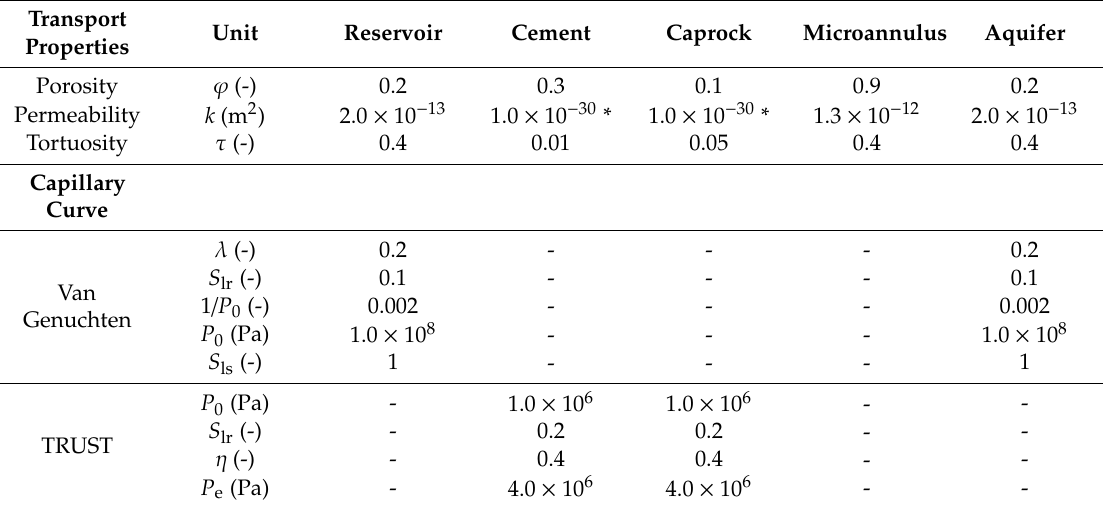
Table 1. Transport properties of the di ff erent materials used in the model. * In TOUGHREACT a